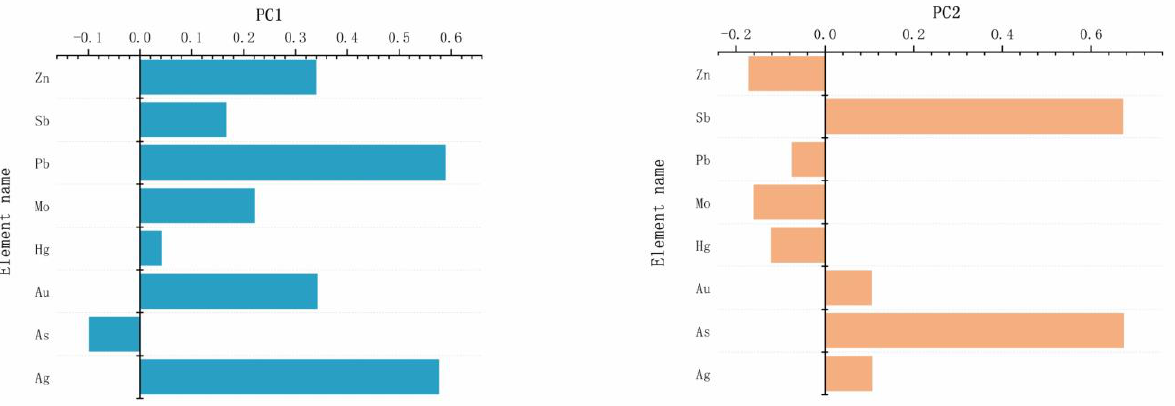
Figure 5. Loading chart for the first and second principal components in the Xiong’er shan